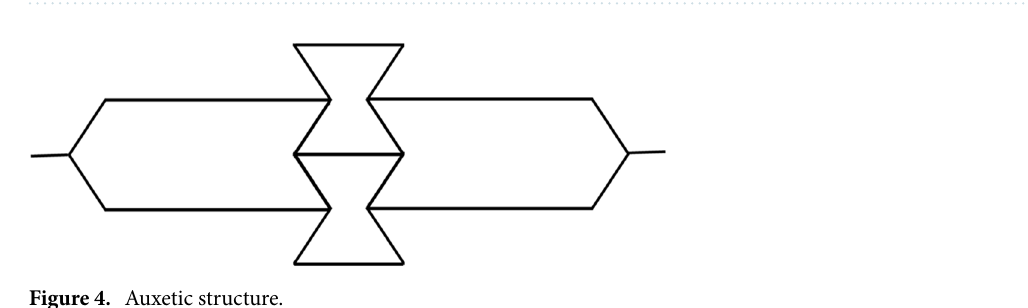
Figure 3. Weave designs used for the repeat zones (Red, Yellow and Green) given in Table 2 using JC5 output file from EAT software.